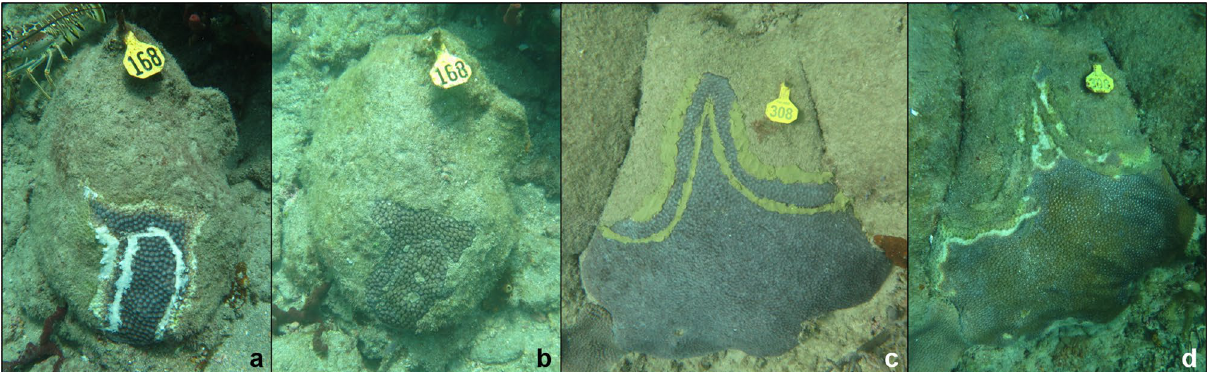
Figure 3. Examples of treated Montastraea cavernosa coral colonies with and without tissue remaining between trenched areas and the initial disease margin. 3a & 3b show a Base 2B plus amoxicillin treated colony ( a ) immediately after treatment application and ( b ) 46 weeks after treatment, with almost all initial coral tissue remaining. 3c & 3d show a representative chlorinated epoxy treated M. cavernosa colony ( c ) immediately after treatment and ( d ) nine weeks after treatment, with the lesions progressing across the